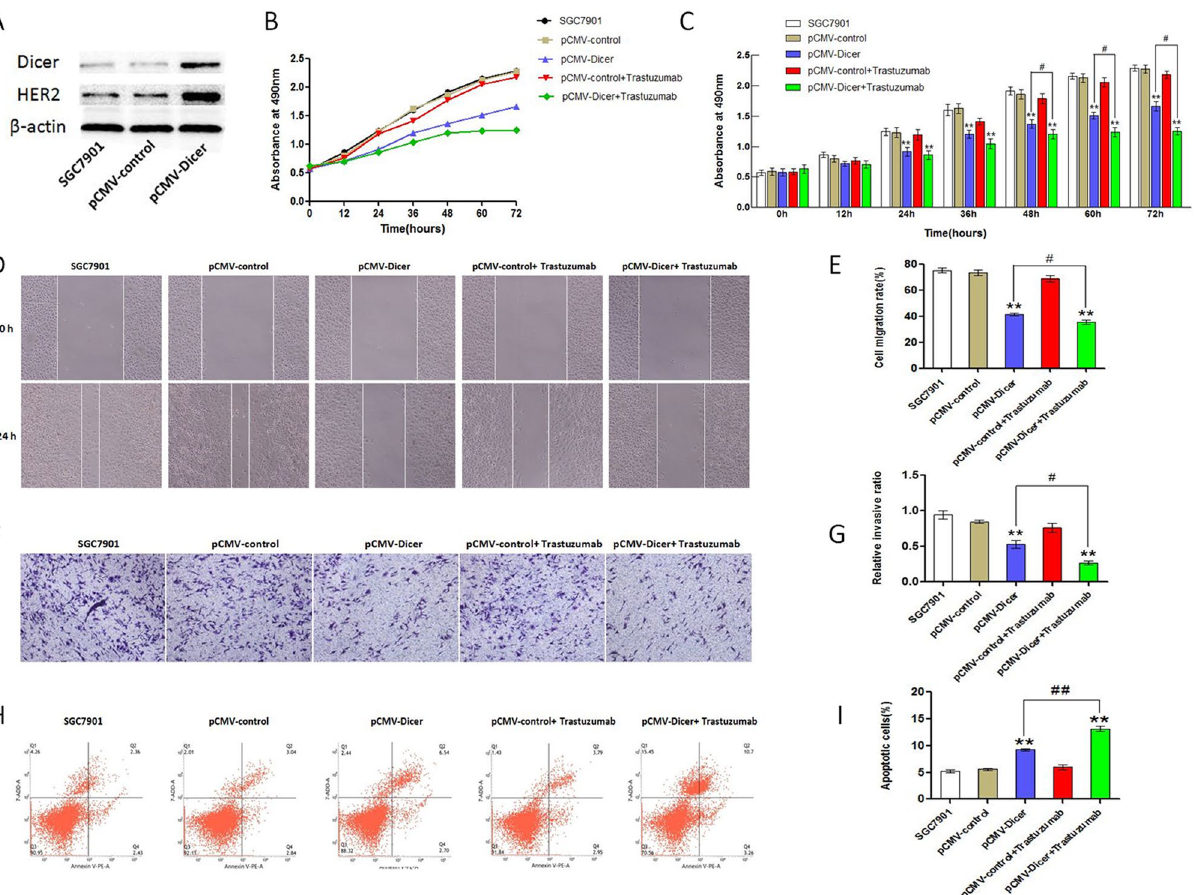
Figure 1. Trastuzumab enhance the Dicer related inhibition for SGC7901 cell. ( A ) Western Blot of Dicer and HER2 in SGC7901 cells. The grouping of gels/blots cropped from diferent parts of the same gel, the full blots are shown in Fig. S4; ( B , C ) The SGC7901 cells proliferation measured with CCK-8 assay; ( D , E ) The SGC7901 cells migration measured by wound healing assay; ( F , G ) The SGC7901 cells invasion measured with transwell